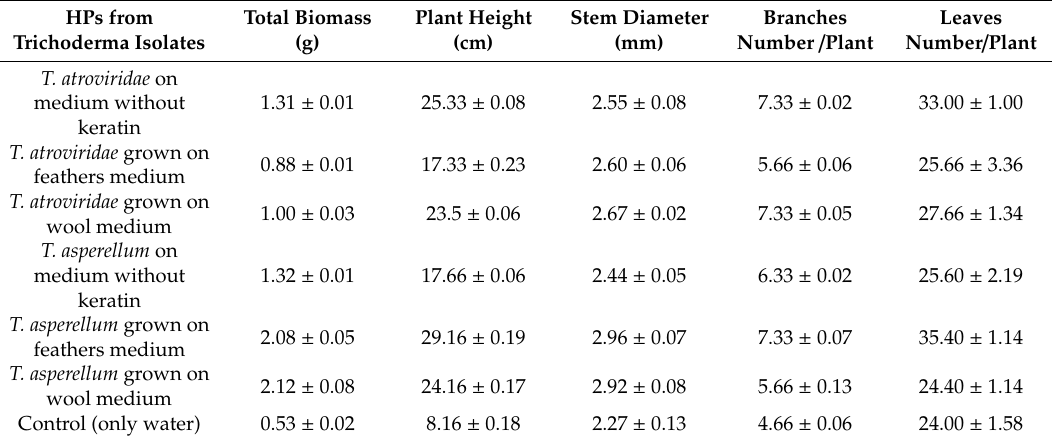
Table 5. E ff ect of fungal PHs on growth parameters after harvest tomato plants under pots experiment ( n =